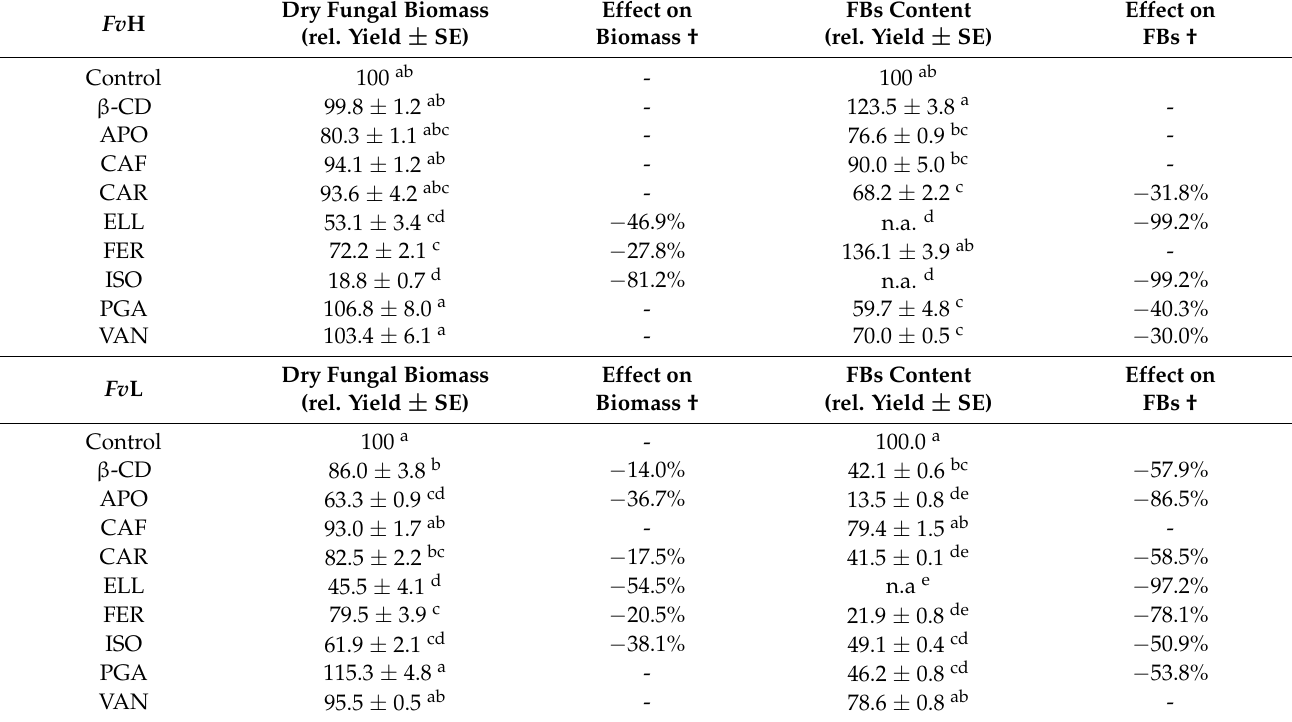
Values were expressed as percentage relative to the level observed in the control culture for Fv H (biomass: 153.0 mg; FBs: 12,950 µ g/kg) and Fv L (biomass: 143.6 mg; FBs: 3650 µ g/kg). FB values were normalized on fungal dry weight. Values with different letters in the rows are significantly different ( p < 0.05). Statistical analyses were performed separately per strain. n.a. not applicable due to FBs content <LOD. † Effect on biomass and FBs was calculated as a percentage change with respect to untreated control data only for the statistically different